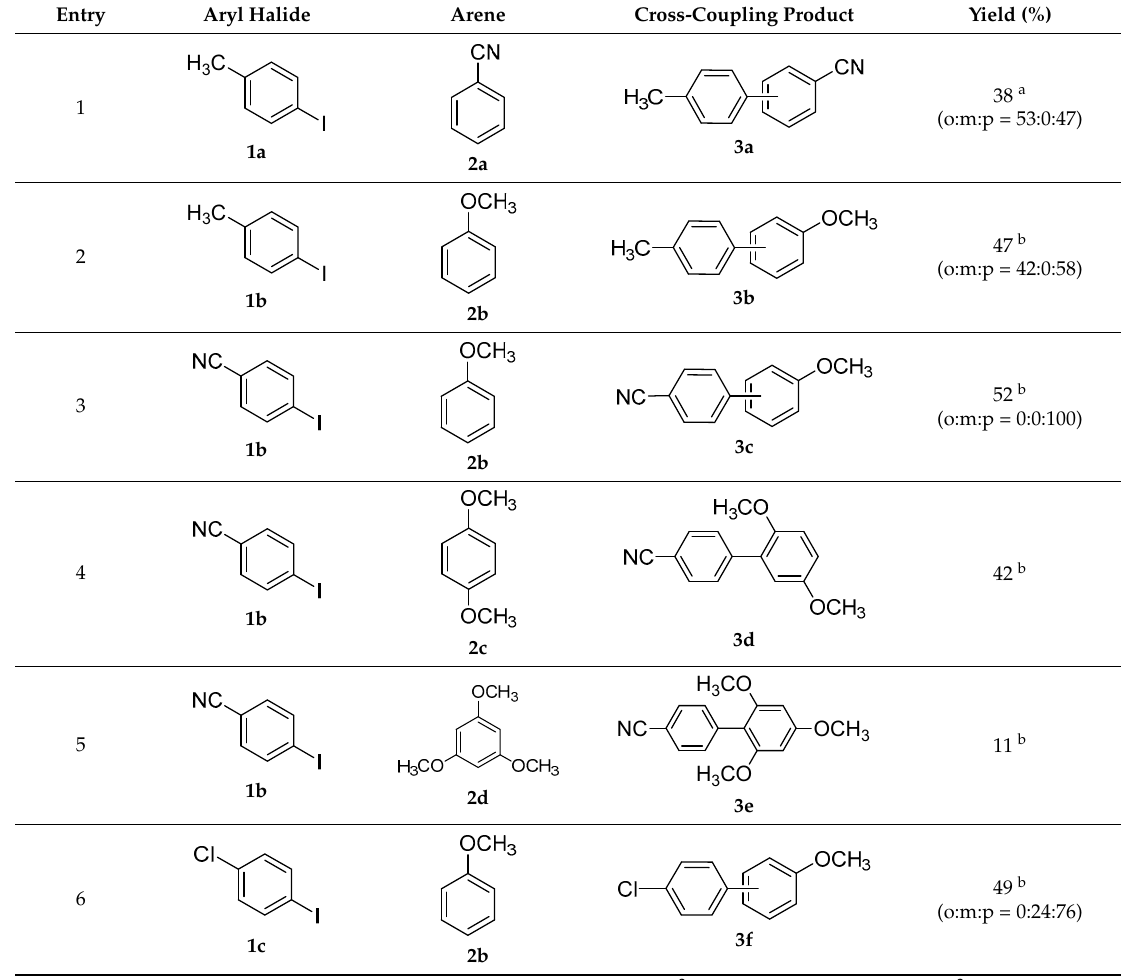
Table 3. Cathodic cross-coupling reaction of aryl halides with arenes. Aryl Halide Arene